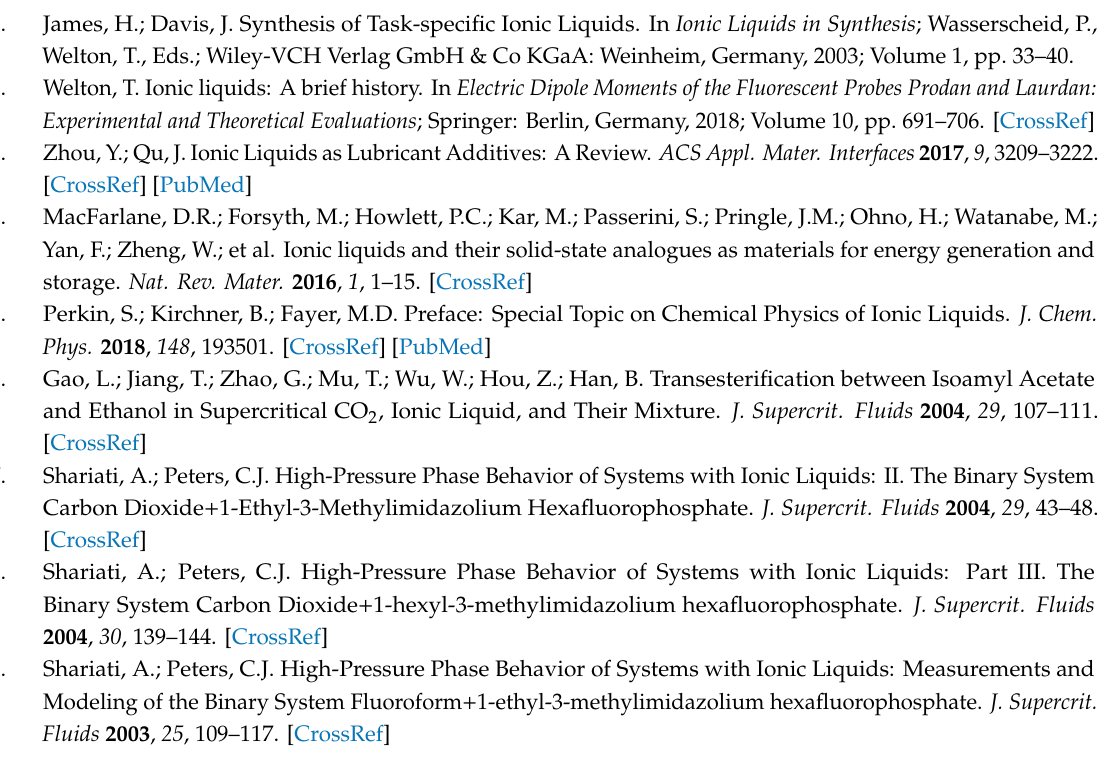
Figure S1: Steady-state excitation and emission spectra of C153 in [P6,6,6,14] + [Tf2N] − / scCO2 at 323 K; Figure S2: Low-energy emission spectra of C153 in [P 6,6,6,14 ] + [Tf 2 N] − / scCO 2